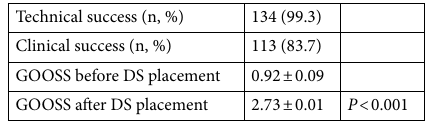
Table 2. Clinical outcomes of duodenal stent placement.